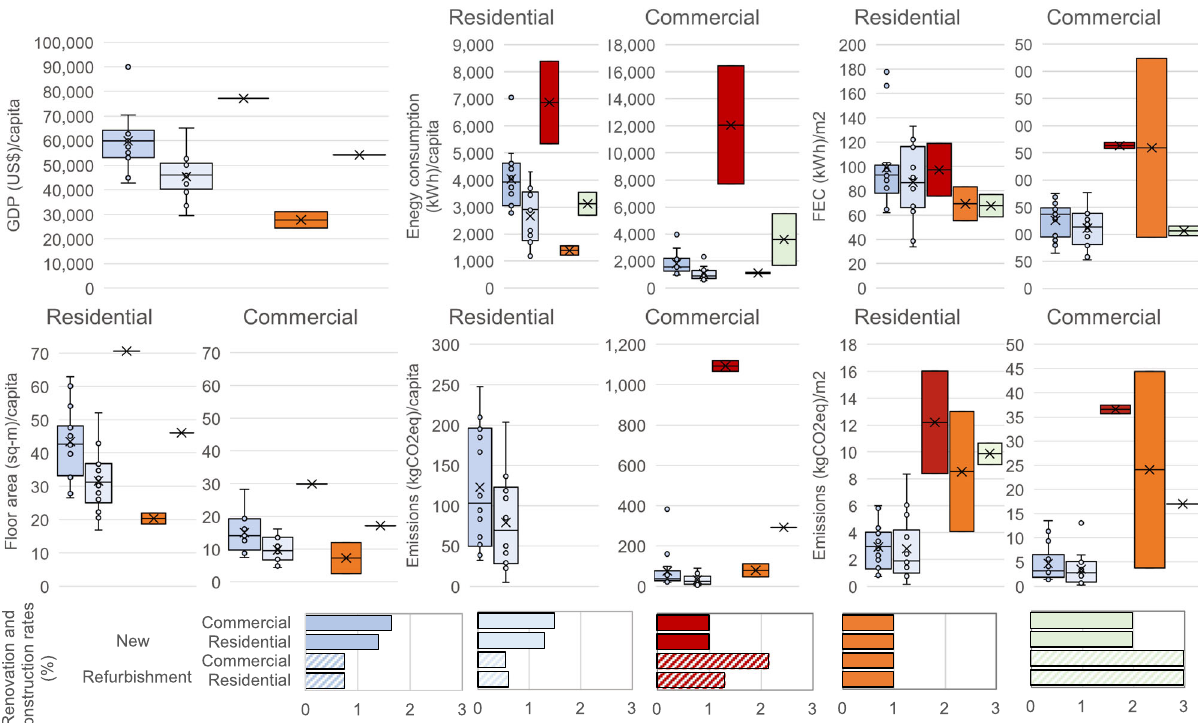
Fig. 3 Decarbonisation Scenarios (Year 2050). Gross domestic product (GDP), fl oor area, annual total fi nal energy consumption (FEC) and CO 2 emissions per capita and per m 2 across regions and countries.